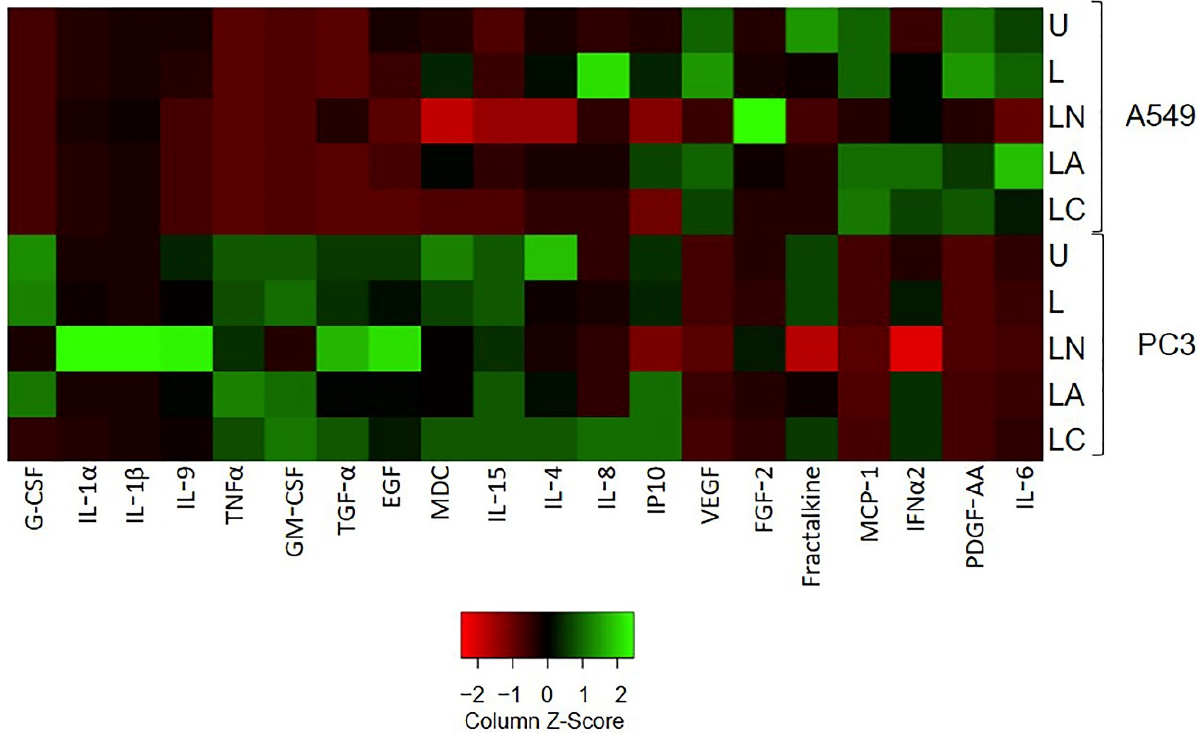
Figure 7. The effect of LPS-Az and LPS-Cf on cytokine secretion in A549 and PC3 cells. The heat map describes changes in the levels of cytokine secretion patterns in A549 and PC3 cells after LPS, LPS-Ng, LPS-Az and LPS-Cf treatments. The cytokines concentrations that were not detected were excluded from the heatmap graphs. U: Untreated, L: LPS, LN: LPS-Ng, LA: LPS-Az, LC: LPS-Cf.